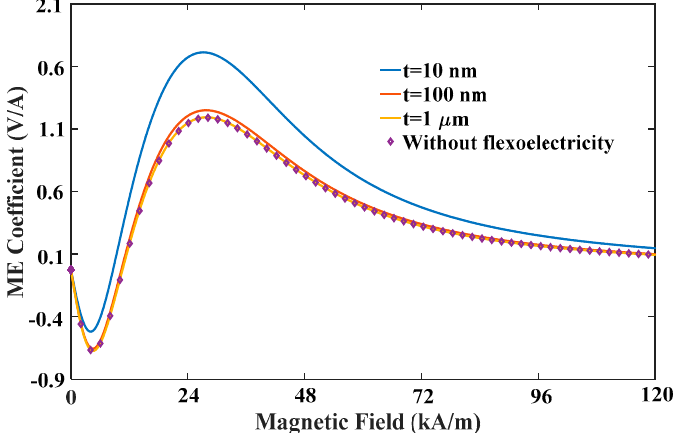
Figure 9. The ME coefficient varied with the applied magnetic field for different total